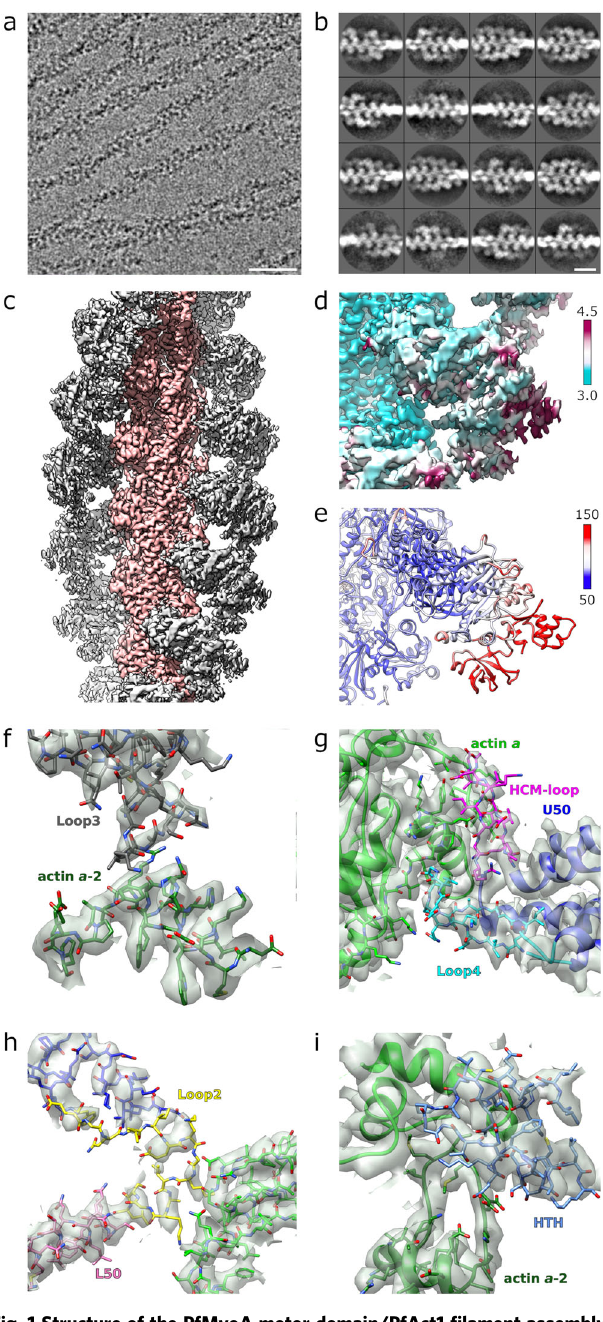
Fig. 1 Structure of the PfMyoA motor domain/PfAct1 fi lament assembly. a Representative micrograph (out of 6073) of JAS-stabilized PfAct1 fi laments with bound PfMyoA motor domain. The scale bar is 50 nm. b Representative classes (out of 1534) from reference-free two- dimensional classi fi cation of segments showing lack of cooperative binding (full decoration). The scale bar is 20 nm. c Reconstruction of JAS-stabilized PfAct1 fi laments (pink) with bound PfMyoA motor domain (gray). The pointed (-) end of the fi lament is up. d Local resolution mapped on the reconstruction. Values of color bar in Å. e Atomic temperature factors mapped on the re fi ned model. Values of color bar in Å 2 f – i Density maps and atomic model for all the actin binding elements of PfMyoA at the actomyosin interface. All the different actin binding elements are colored differently: The hypertrophic cardiomyopathy loop (HCM) in pink; Loop2 in yellow; Loop3 in dark gray; helix-turn-helix (HTH) in dark blue (see also Supplementary Fig.